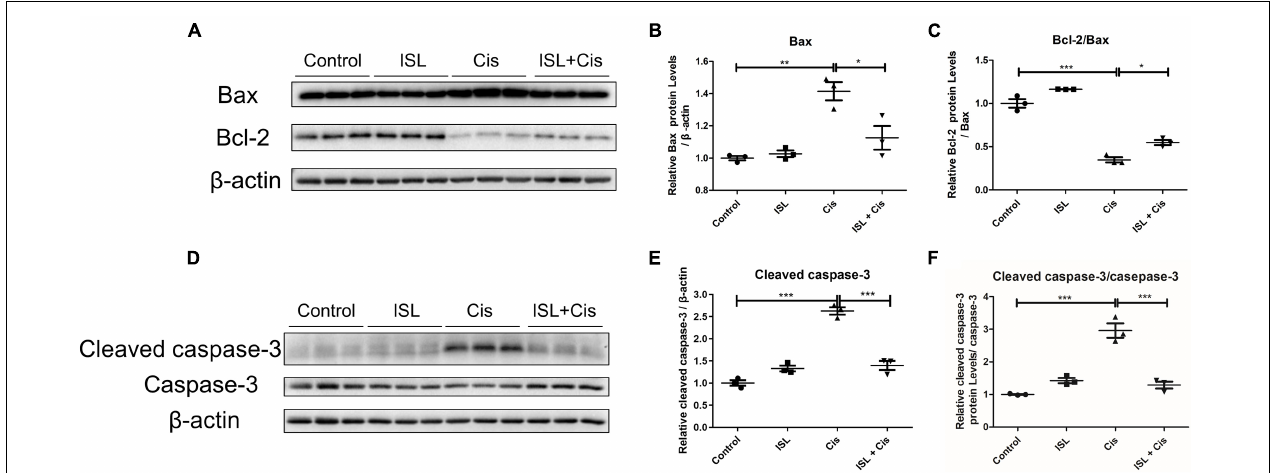
FIGURE 2 | ISL alleviated cisplatin-induced apoptosis in mPTCs. mPTCs were pretreated with 62.5 µ M ISL for 6–8 h and then incubated with 5 µ g/mL cisplatin for 24 h. (A) The protein levels of Bax and Bcl-2 were detected by western blotting. β -actin was used as an internal reference. (B,C) Densitometry analysis of Bax (B) and Bcl-2/Bax (C) . (D) Protein levels of cleaved caspase-3 and caspase-3 were detected by western blotting. β -actin was used as an internal reference. (E,F) Densitometry analysis of cleaved caspase-3/ β -actin (E) and cleaved caspase-3/caspase-3 (F) . The quantitative results are expressed as the mean ± SD of each group ( n = 3 per group). * p < 0.05, ** p < 0.01, *** p < 0.001 (ANOVA with multiple